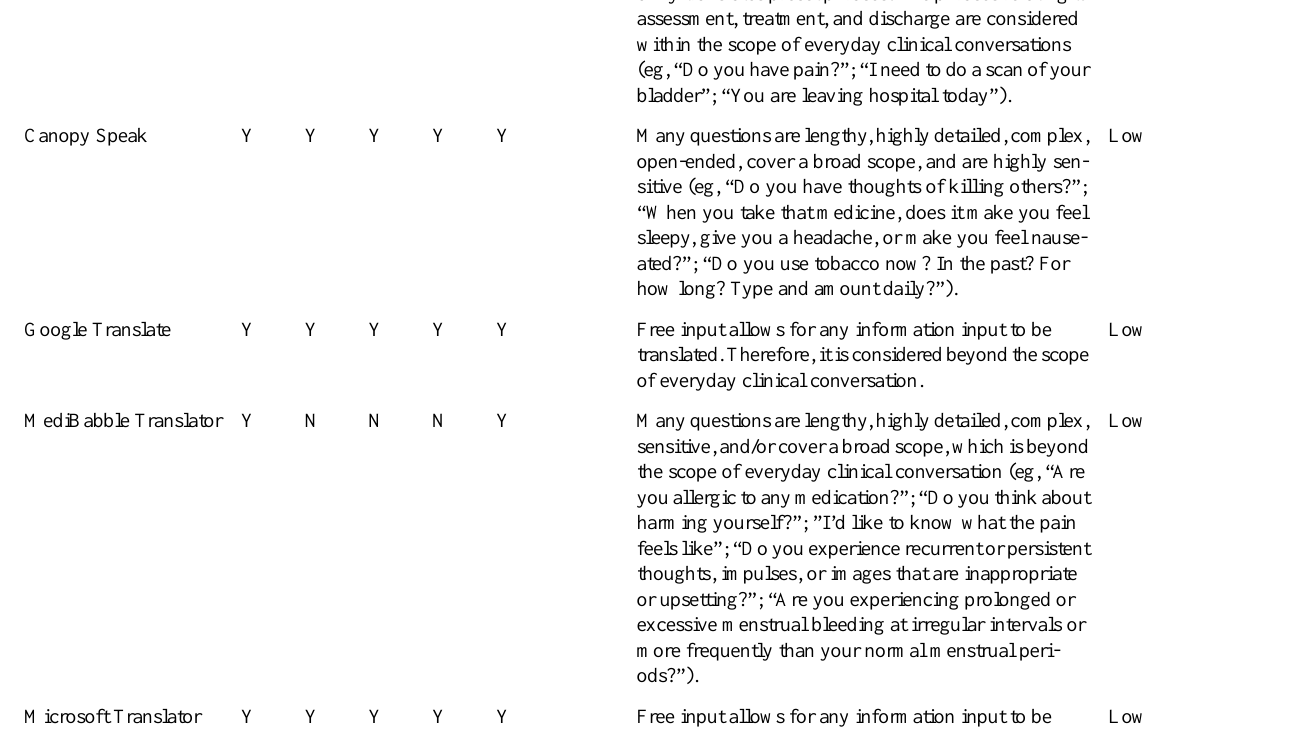
Overall rating of suitability for